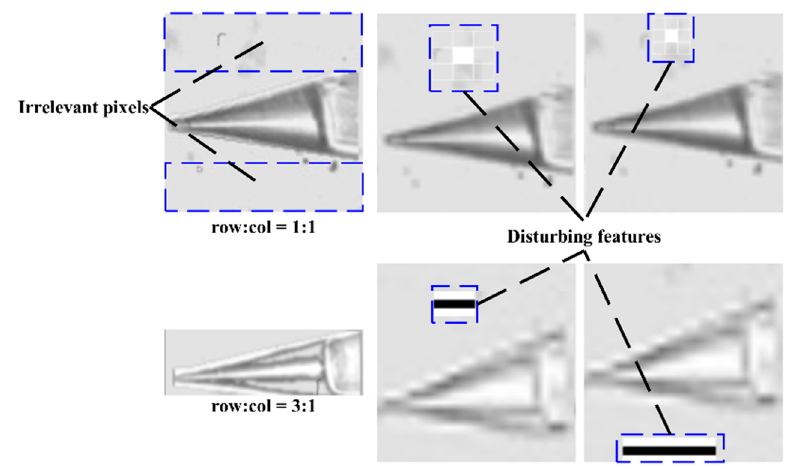
Figure 21. Irrelevant pixels and disturbing features.